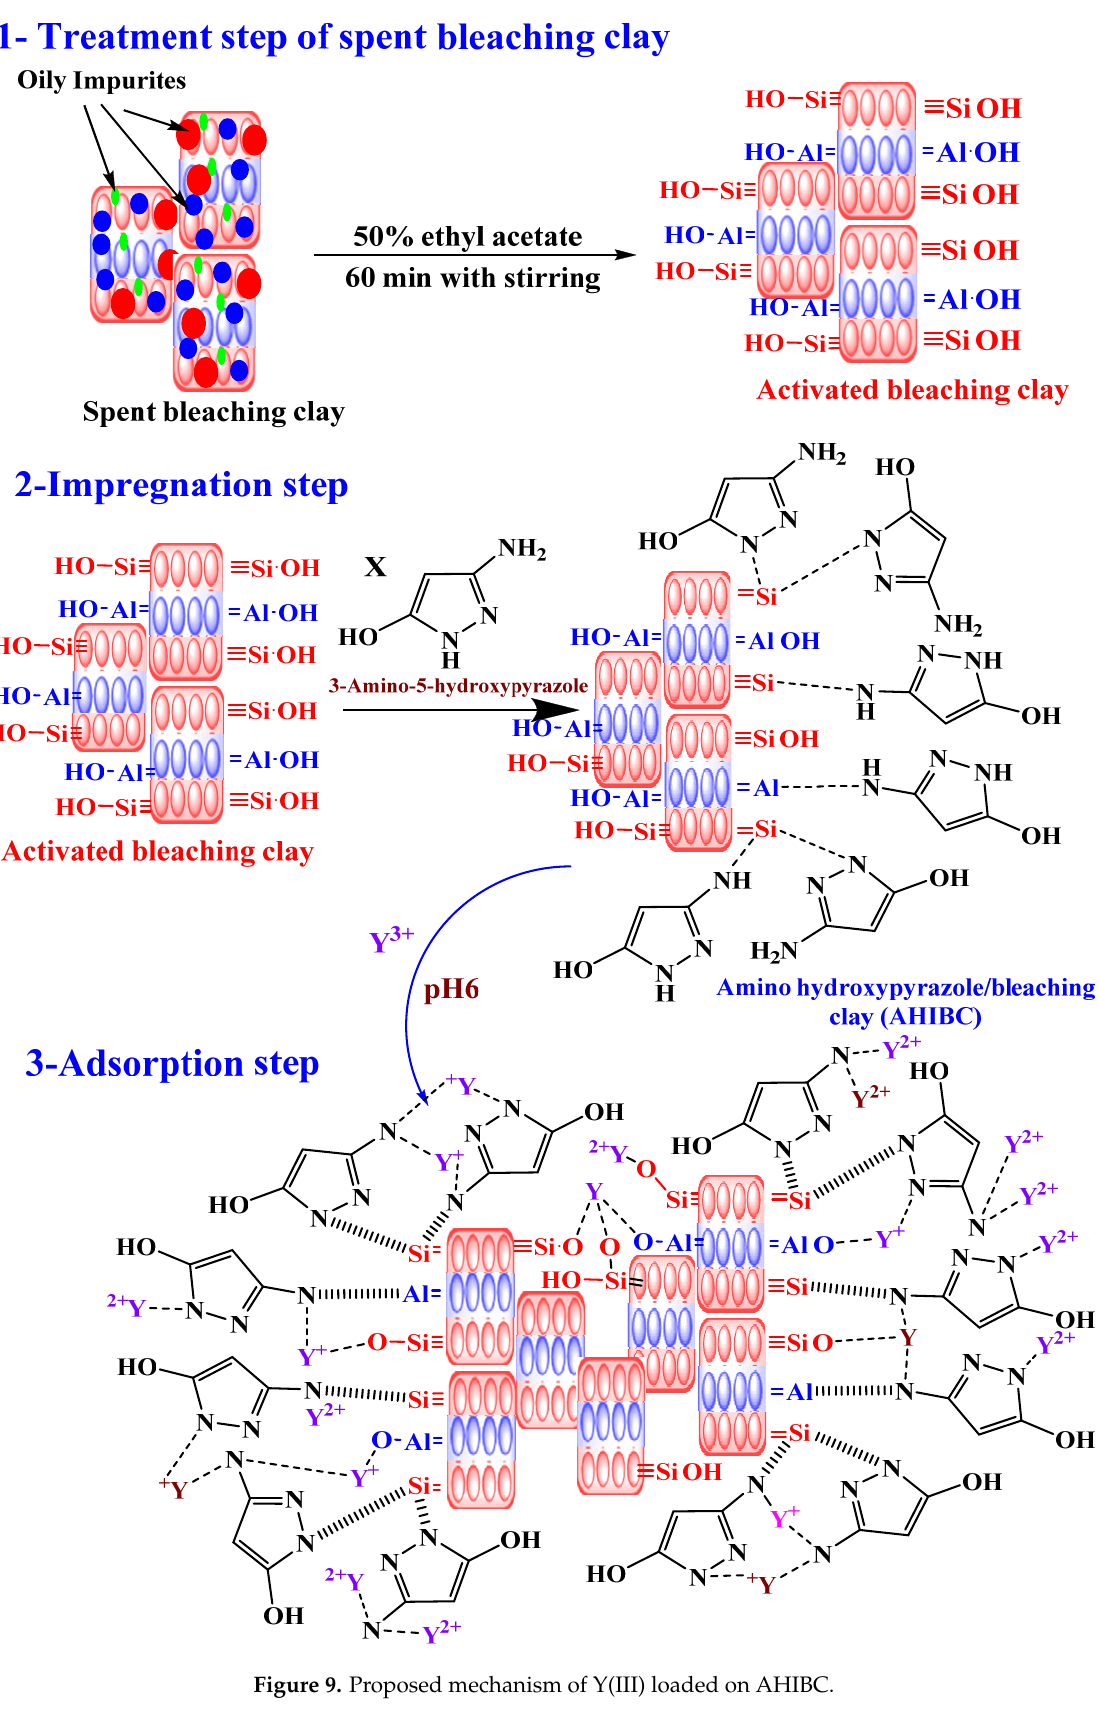
Figure 9. Proposed mechanism of Y(III) loaded on AHIBC.